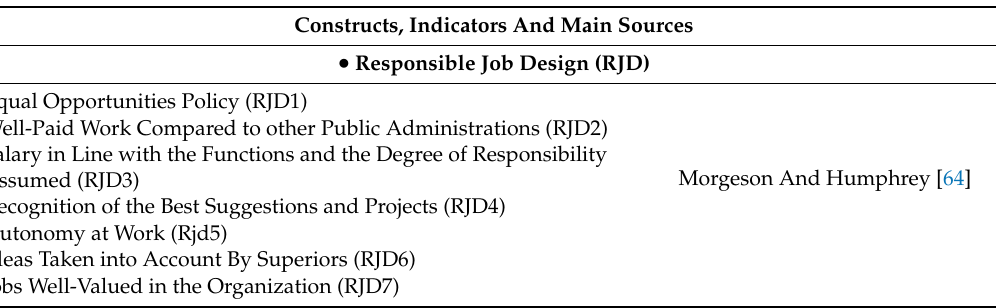
Table 1. Measurement